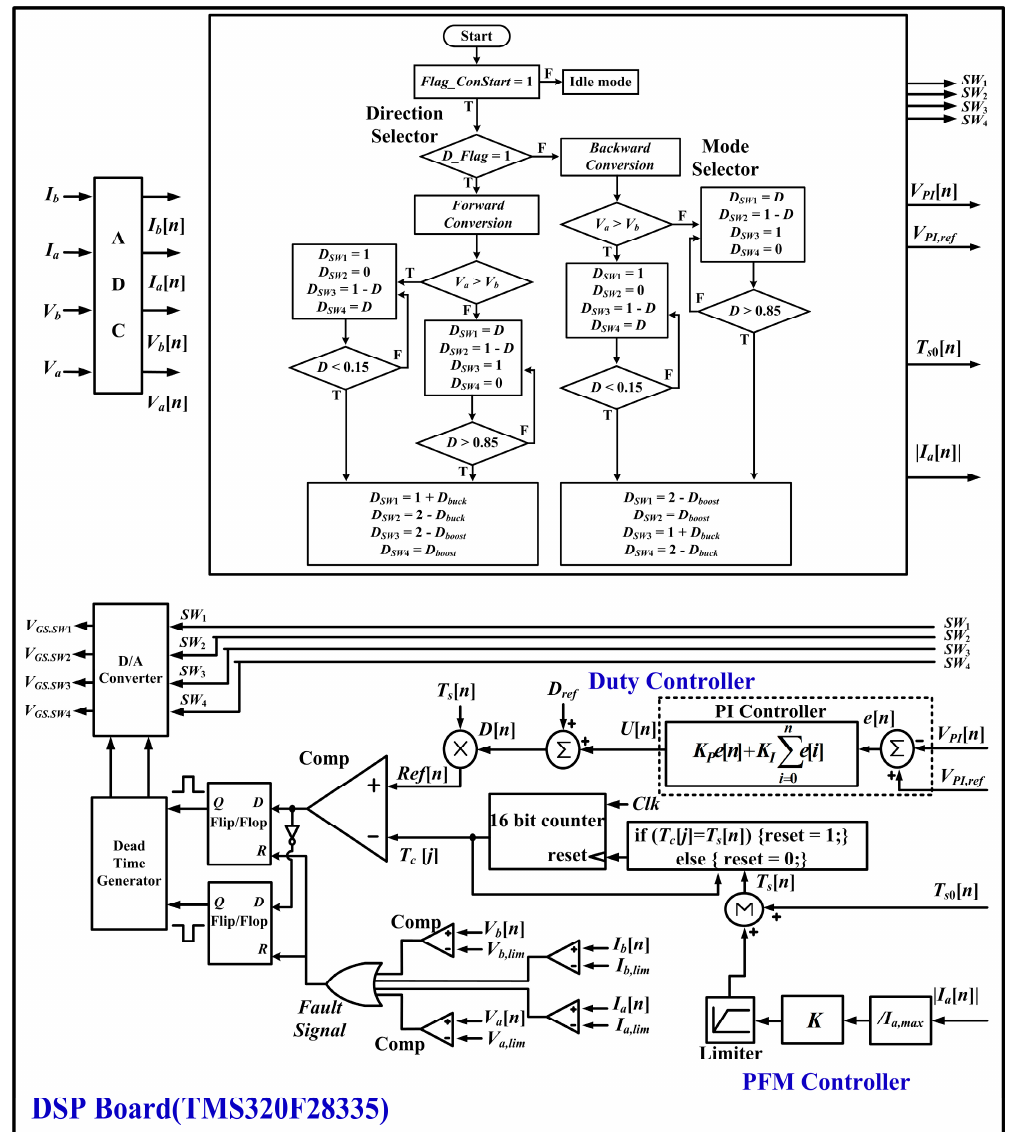
Figure 11. Block diagram of the digital controller. DSP: digital signal processor; PFM: pulse-frequency modulation.